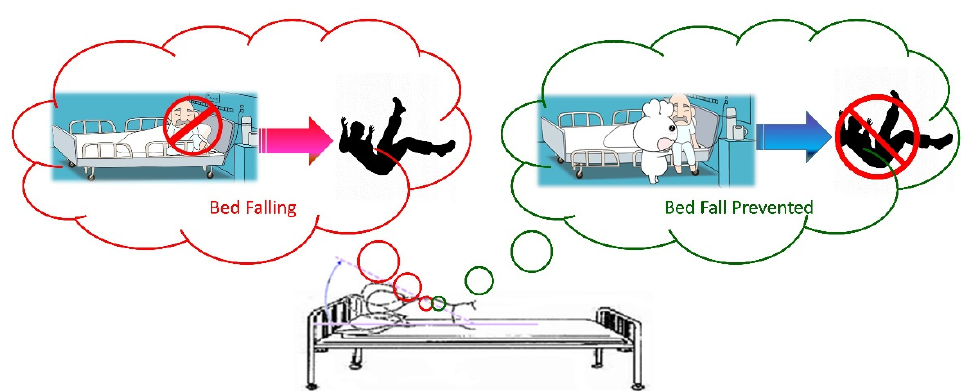
Figure 1. Bed fall prevention through posture change (from lying down to sitting up) detection and warning.